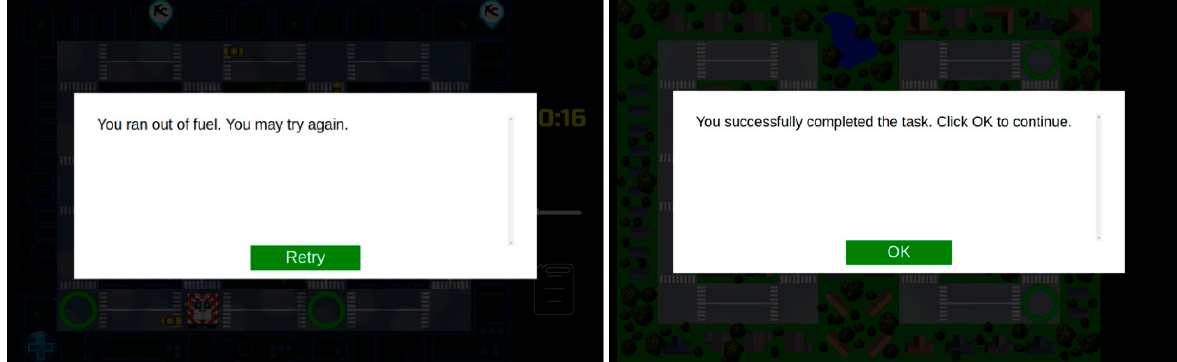
Figure 5. Screenshots of two pages prompting participants to repeat the task (left) and to continue (right).